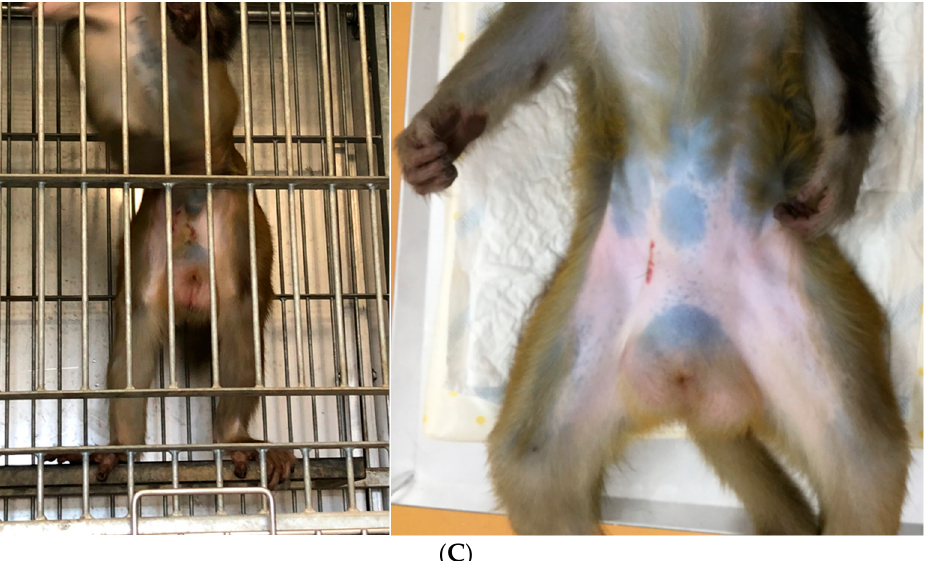
Figure 2. ( A ) Example of a complication after hernia repair in the right groin region (photograph provided by Biomedical Primate Research Centre); ( B ) three years after a left side castration and vasectomy of the right vas deferens the right testis appears enlarged and firm on palpation (photograph provided by Biomedical Primate Research Centre); ( C ) photos made two days after a hernia repair (open surgery, sutures), which was combined with unilateral castration (right side). (Photograph provided by Biomedical Primate Research Centre).